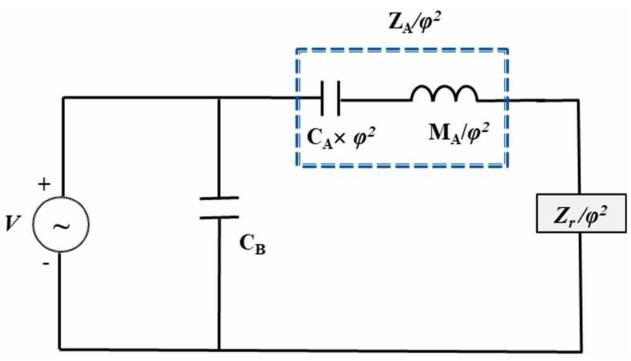
Figure 3. Equivalent circuit of the multilayered